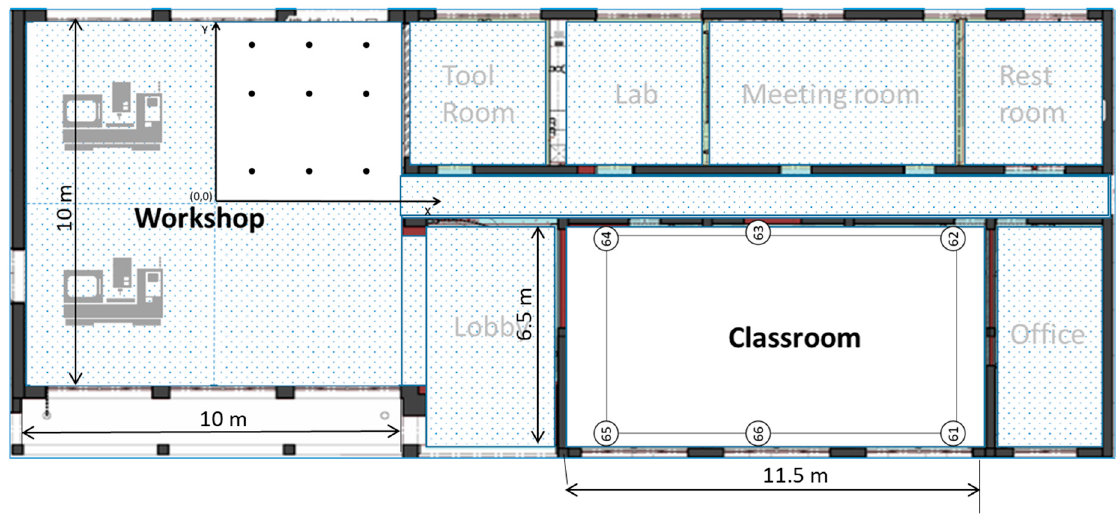
Figure 4. Experiment field layout (workshop and classroom).